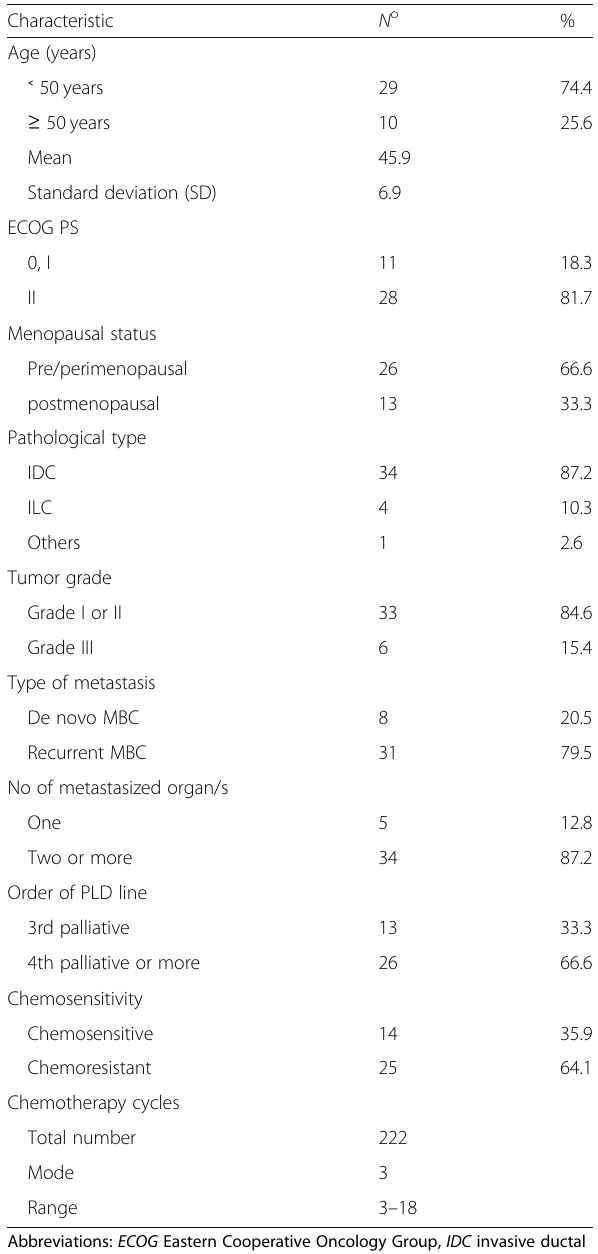
Table 1 P atients ’ demographics and tumor